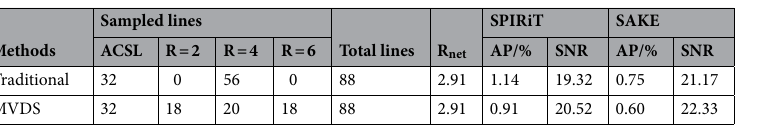
Table 6. The AP and SNR of the reconstruction images using SPIRiT and SAKE with both traditional uniform subsampling and proposed MVDS.